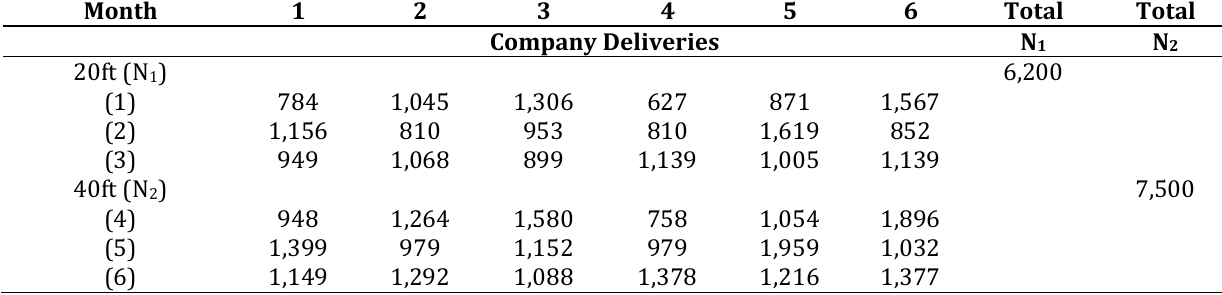
Table 3: Stuffing and Delivery for 12 months by three Companies (1, 2,